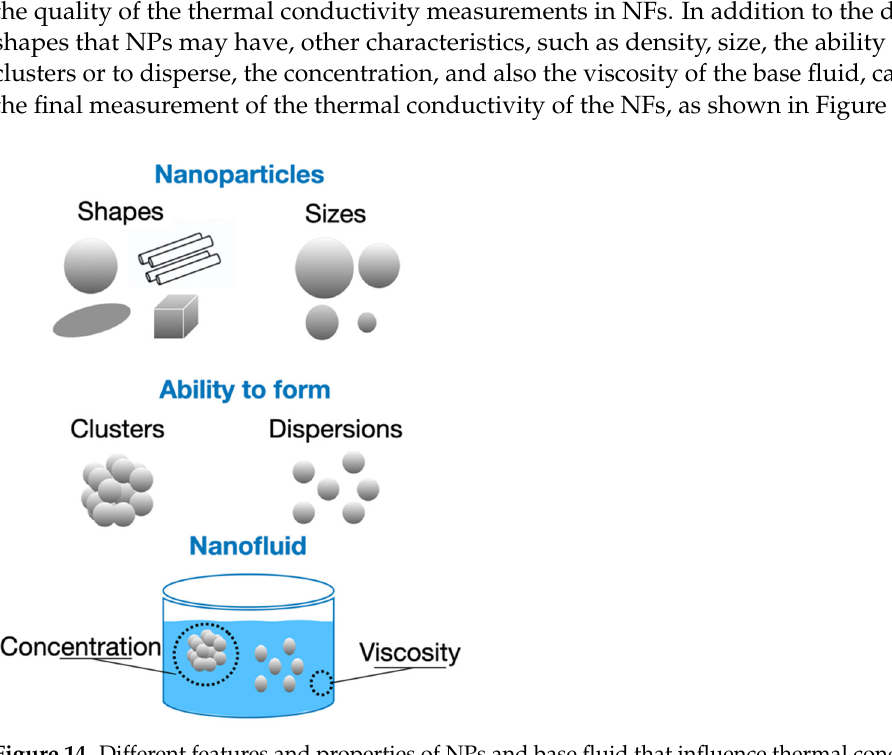
Figure 14. Different features and properties of NPs and base fluid that influence thermal conductiv- ity measurements.